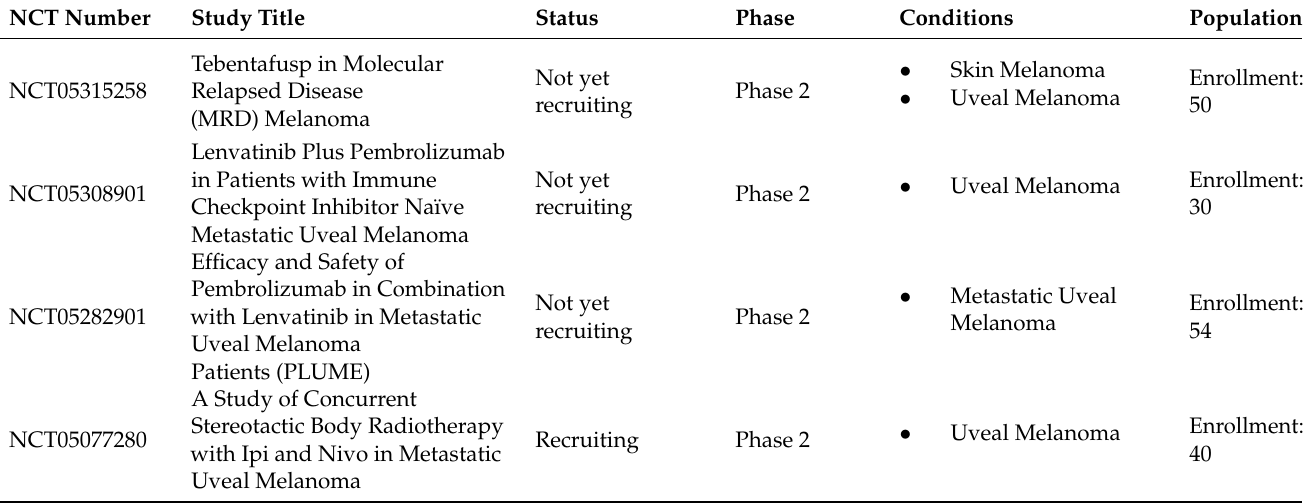
Table 2. Ongoing clinical trials with immunotherapies in UM and metastatic